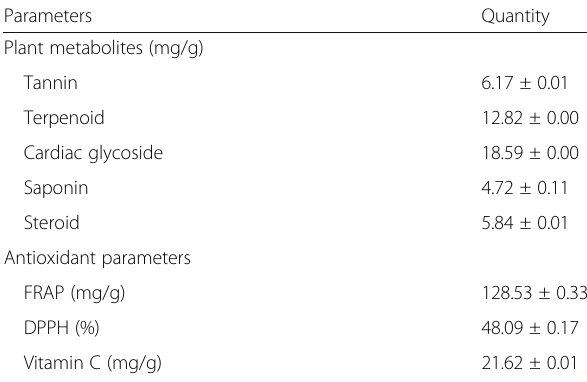
Table 1 Chemical composition and antioxidant properties of pawpaw leaf and seed meal composite mix